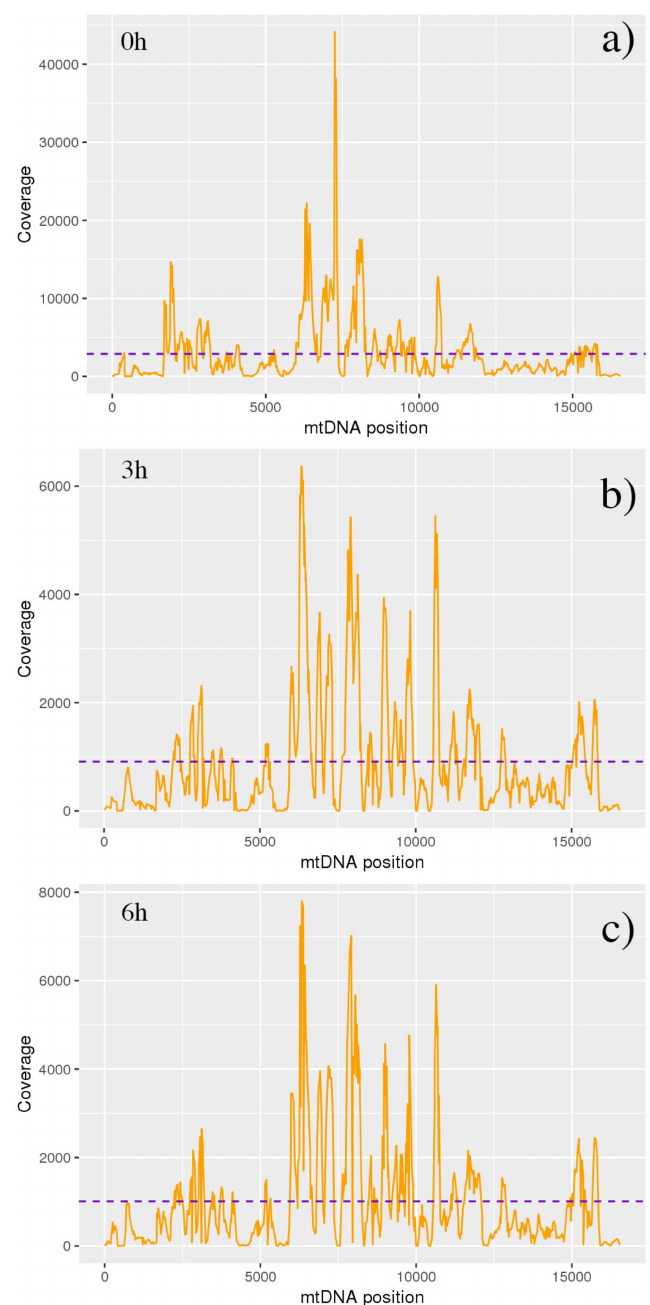
Figure 7. MtDNA-Server coverage plots. Figure shows coverage for each RNA-Seq sample, evaluated in all time-related conditions ( a = 0 h, b = 3 h, c = 6 h). Coverage analysis permitted the detection of issues with incorrect concentration of polymerase chain reaction products for the used fragments. The highest coverage was reached around the 7500 nt position in untreated sample ( a